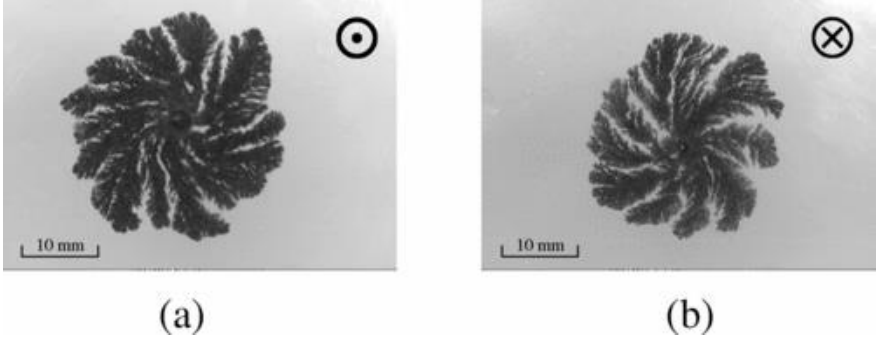
Figure 1. Zinc electrodeposited from a 0.1 M ZnSO 4 aqueous solution at 10 V, in a flat horizontal cell, with 0.35 T magnetic field intensity. The latter is applied ( a ) vertically upward or ( b ) vertically downward (Reproduced with permission from [13]. The American Physical Society, 2004).